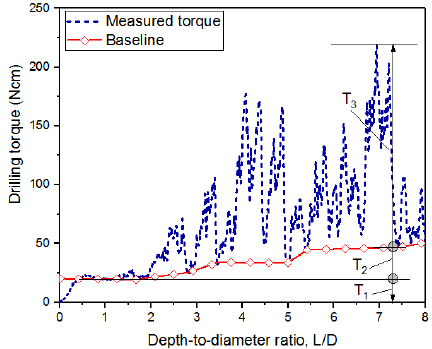
Figure 1. The three components of the drilling torque.